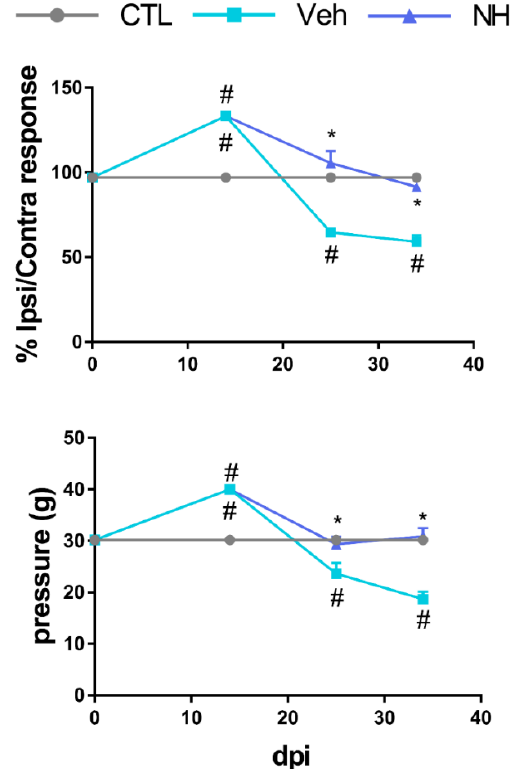
Figure 3. NeuroHeal reduces hyperalgesia after peripheral nerve injury (PNI). Changes in mechanical